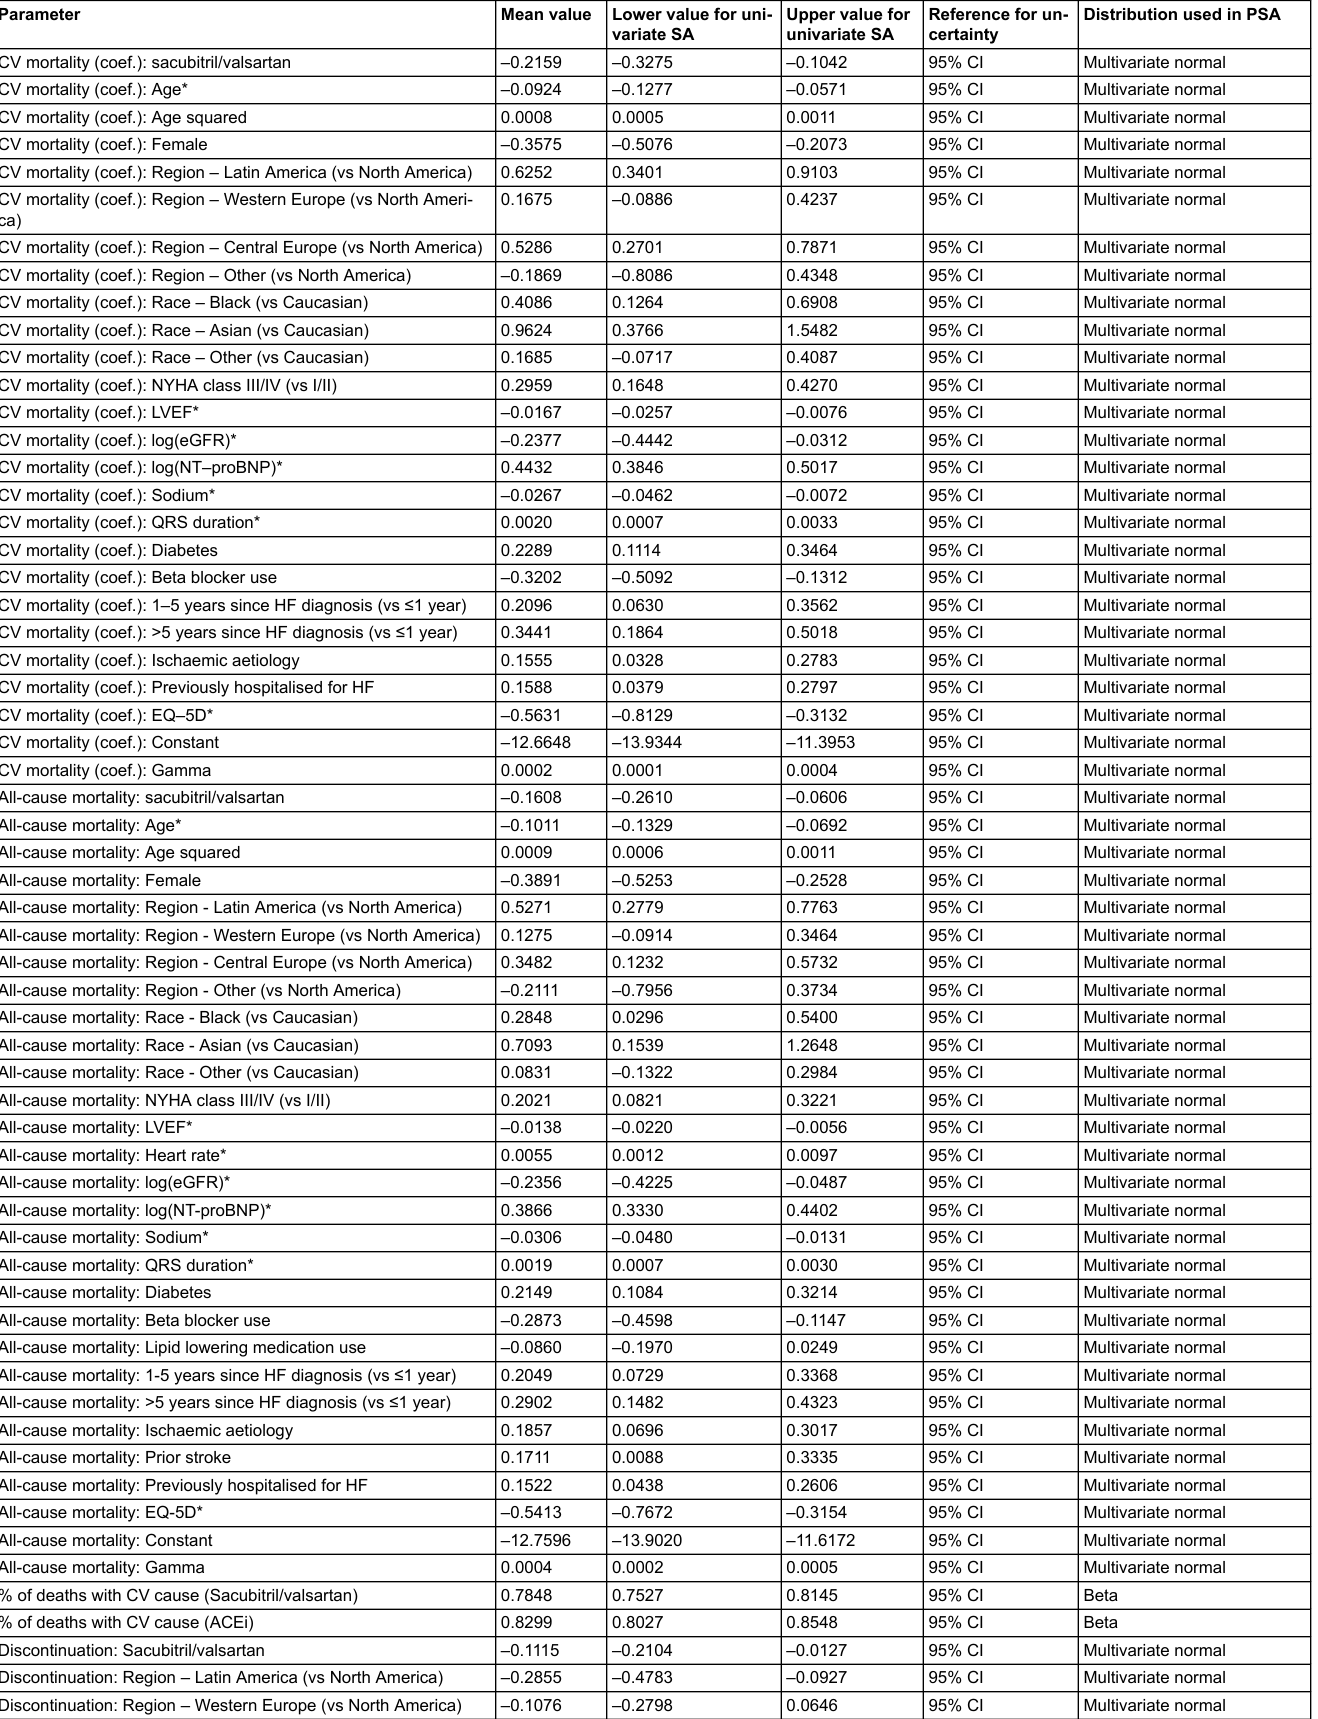
Table S12: Parameters used in univariate and probabilistic sensitivity analyses. Cost parameters are in